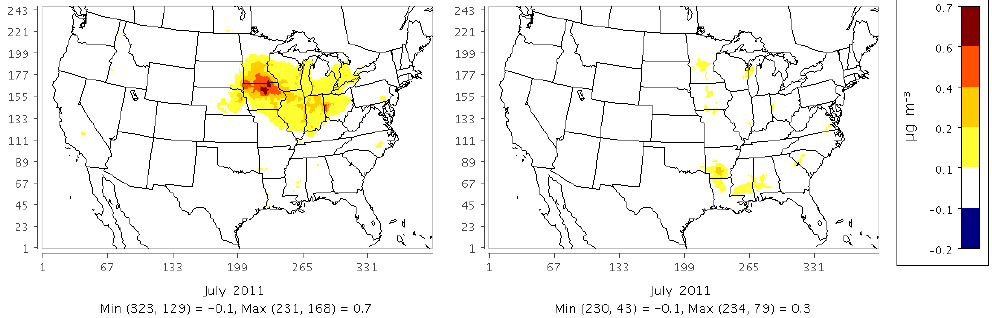
Figure 8. Changes in modeled daily average PM 2 . 5 when switching from (a) YL to BDSNP ( et al. (2010) fertilizer data with original biome map) (left) and (b) BDSNP ( et al. (2010) with original biomes) to BDSNP (EPIC with new biomes) (right).